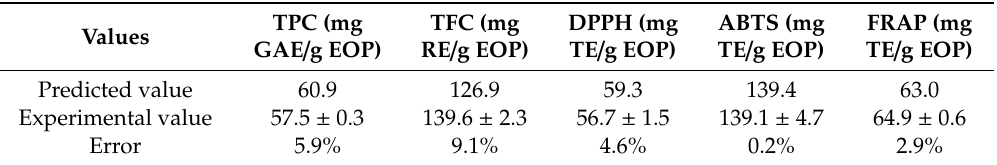
Table 4. Predicted and experimental ultrasound-assisted etraction (UAE) values of EOP in the optimal conditions that simultaneously maximised the five responses.